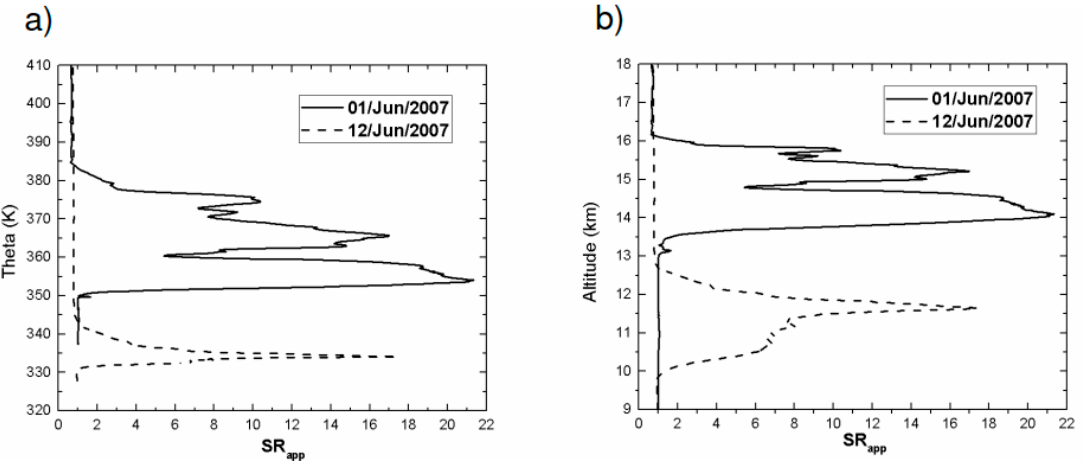
Figure 1. SR app profiles on 1 June (solid line) and 12 June (dashed line) 2007 derived from the São Paulo lidar, according to the potential temperature (from local radiosounding) ( a ) and the corresponding altitudes ( b ).